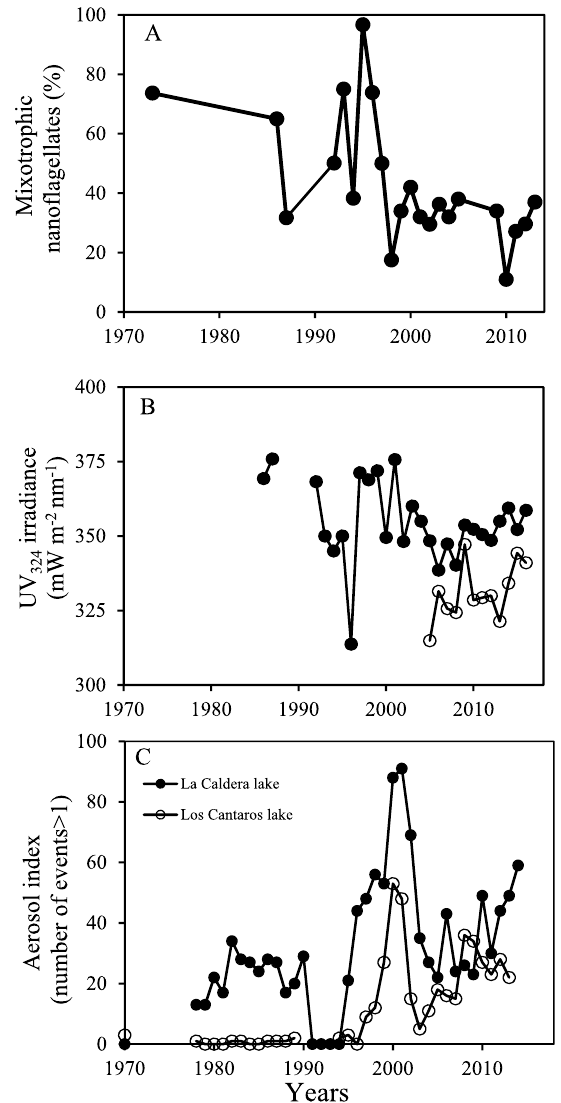
Figure 1. Interannual trends in mixotroph nanoflagellates (MNFs), UVR irradiance, and aerosol events. ( A ) Mean annual changes in percentage of mixotroph nanoflagellates (MNFs) during ice-free seasons between 1973 and 2014 in Lake La Caldera; ( B ) UV 324nm irradiance in both area lakes; ( C ) Aerosol index (AI), number events AI > 1 is sum of the daily of events AI > 1 for the ice-free period considered for each lake area and year from 1978 to